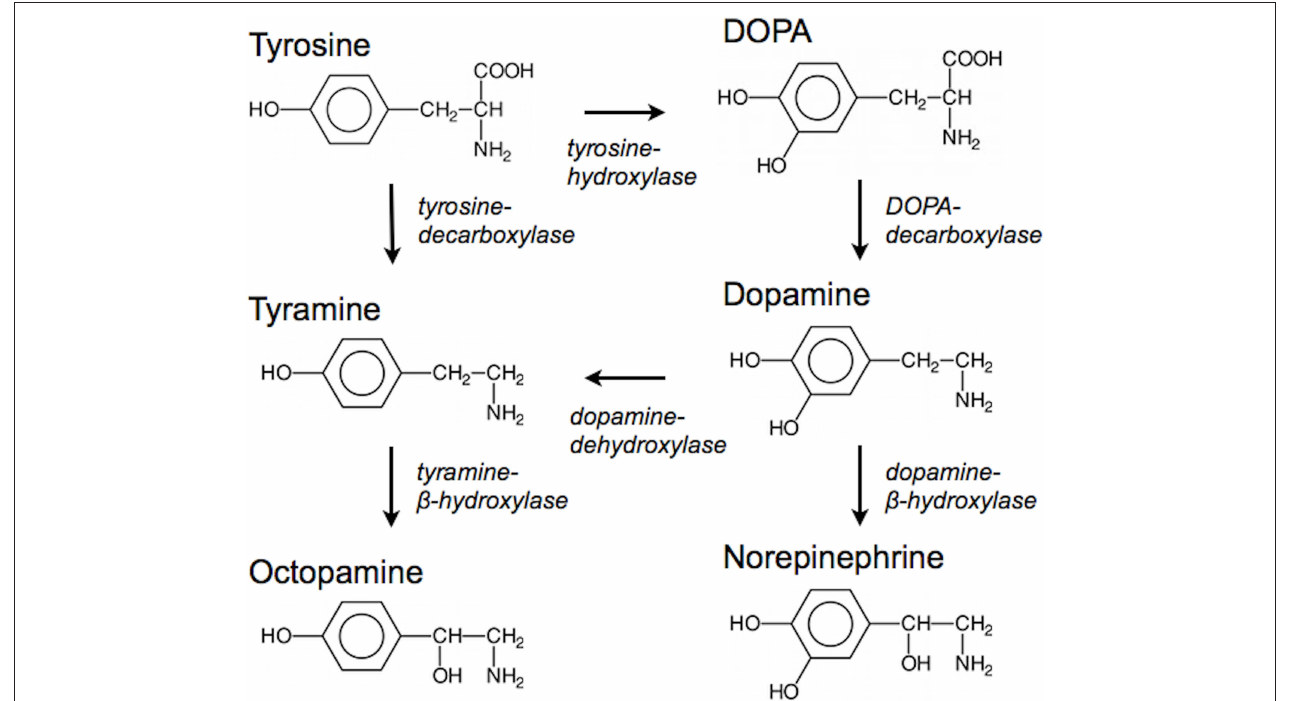
tyrosine-decarboxylase , or (more rarely) dehydroxylated from dopamine by dopamine-dehydroxylase . This figure summarizes the most common synthesis pathways, but there are variations among the phyla. In some groups, octopamine is a trace amine and synthesized from tyramine by dopamine- β - hydroxylase, while in other phyla, norepinephrine is physiologically irrelevant and not present at any biologically meaningful